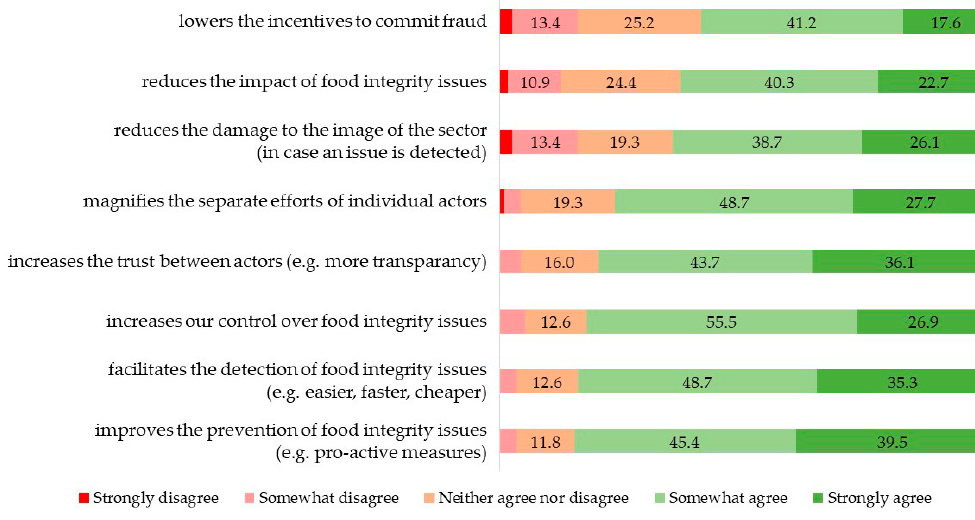
Figure 2. Perceived advantages of information sharing to prevent and detect food integrity issues according to food industry actors ( n = 119, %).